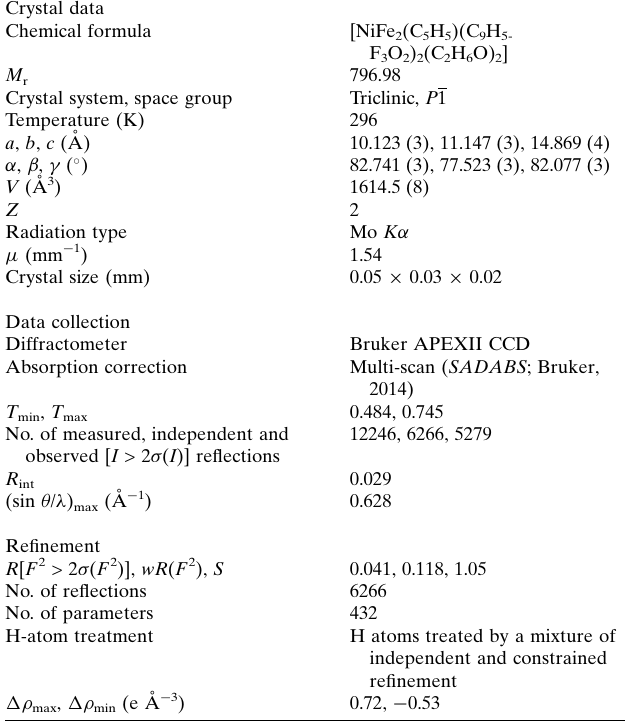
Table 2 Experimental details.